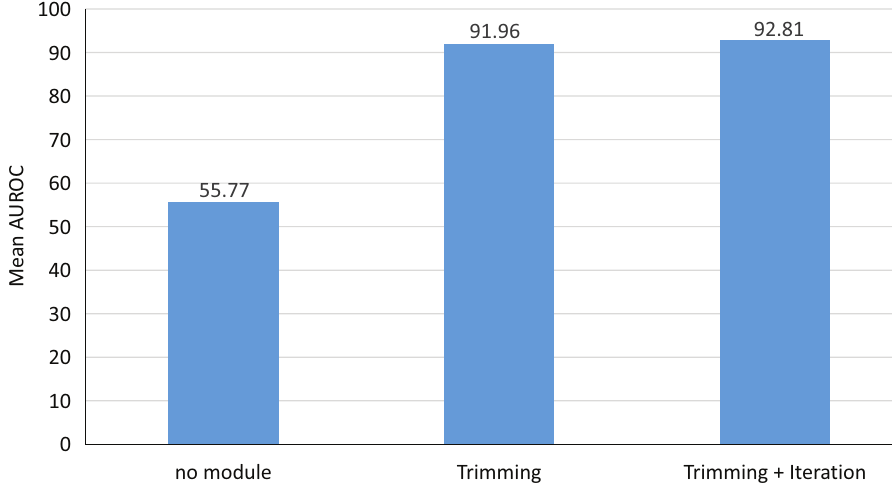
Figure 13. Trimming and iteration module performance testing.